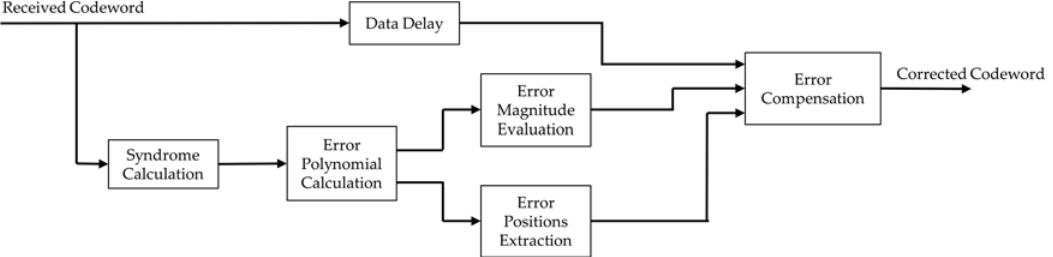
Figure 2. Traditional RS decoder scheme.